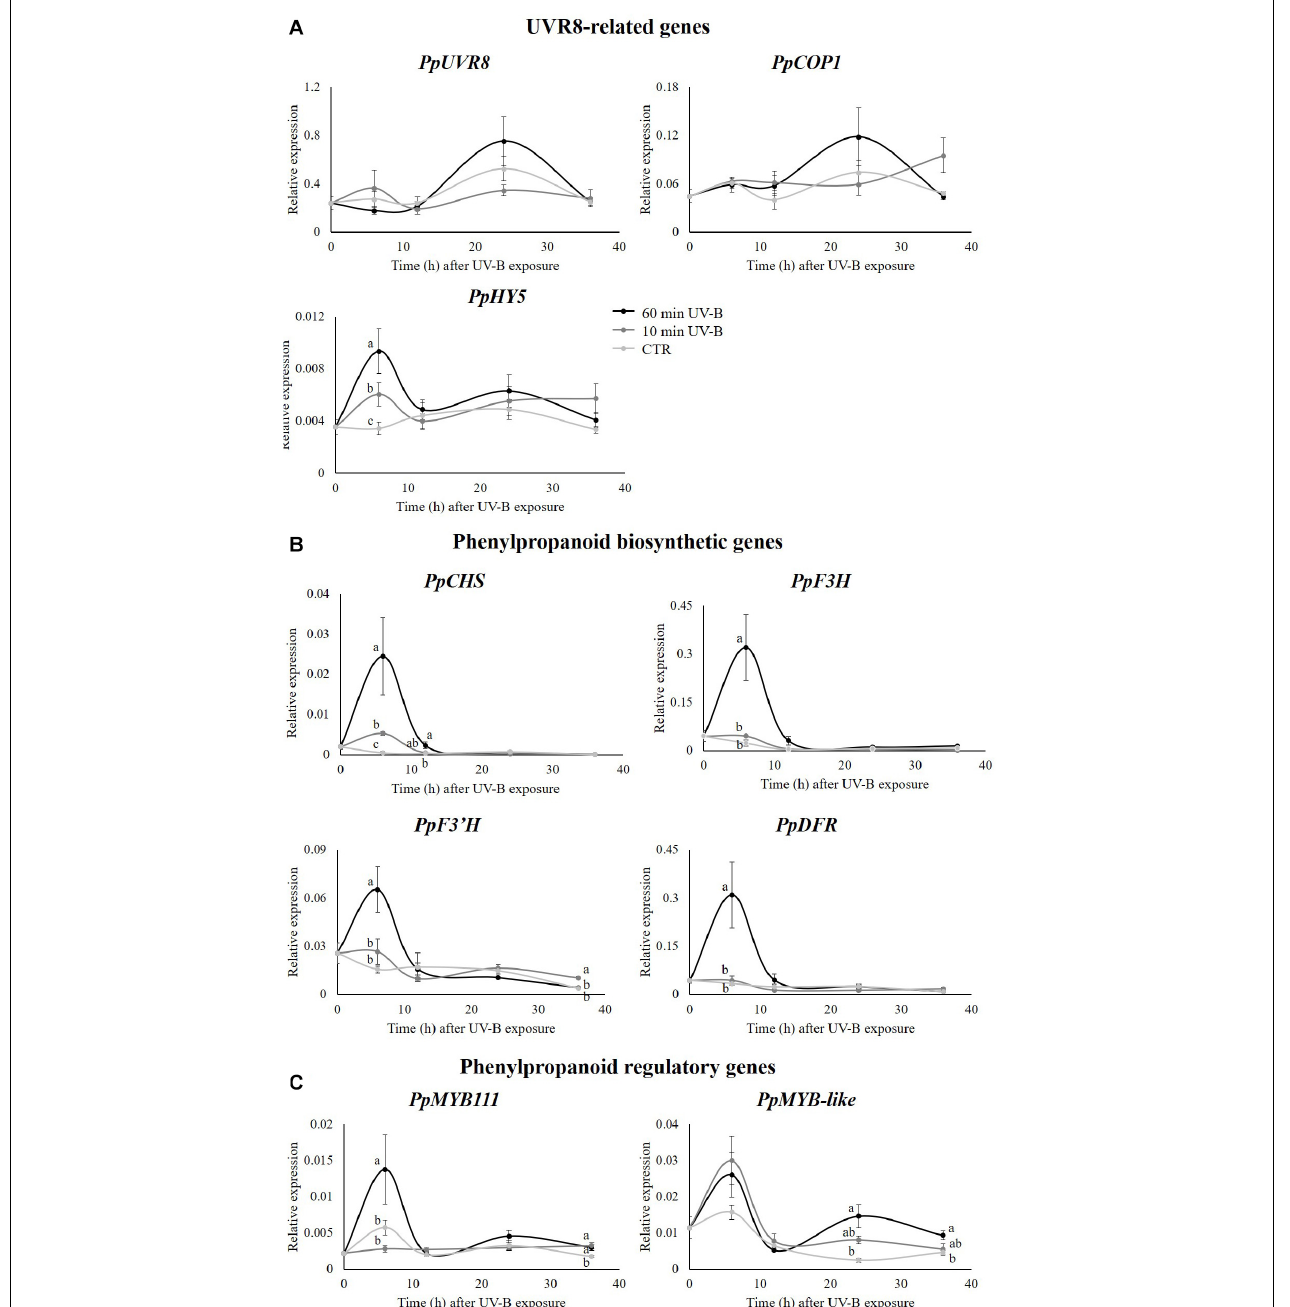
FIGURE 7 | Transcript level of: (A) some genes involved in UVR8 pathway (UVR8, COP1, HY5), (B) some structural (CHS, F3H, F30H, DFR) and (C) some regulatory (MYB111, MYB-like) genes involved in phenylpropanoid biosynthesis in the pulp of peaches exposed to UV-B radiation for either 10 or 60 min, and sampled after 24 and 36 h from the exposure. Data are mean ± SE of five biological replicates. Different letters correspond to statistically significant differences according to one-way ANOVA followed by Tukey–Kramer post hoc test ( P ≤ 0.05).